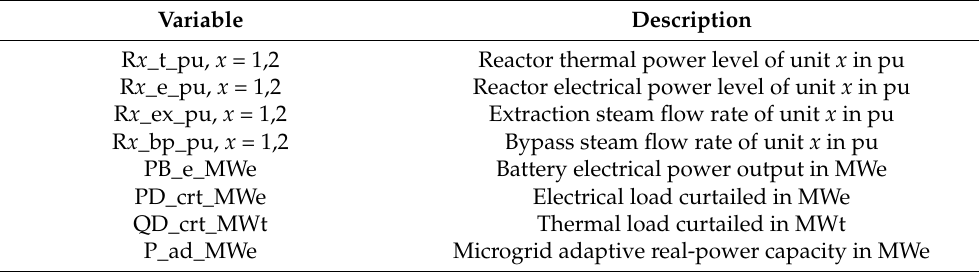
Table 2. Description of variables plotted in Figures